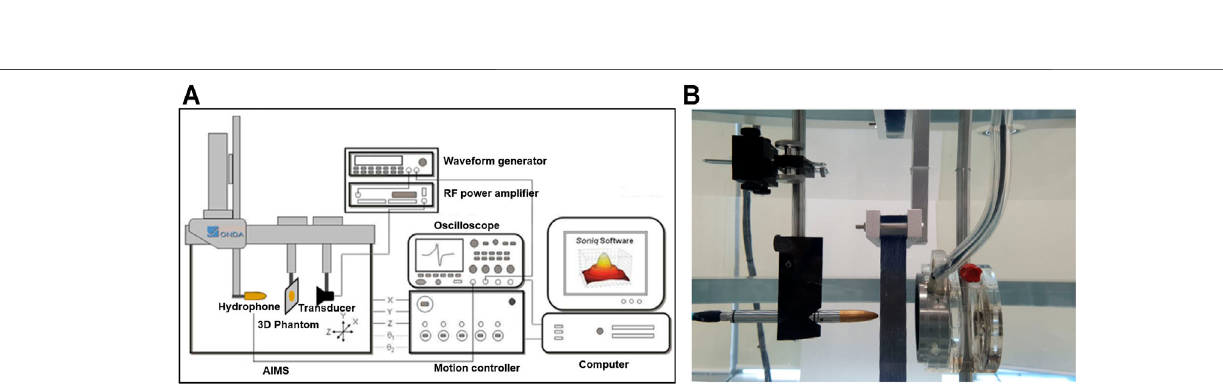
Frontiers in Bioengineering and Biotechnology |